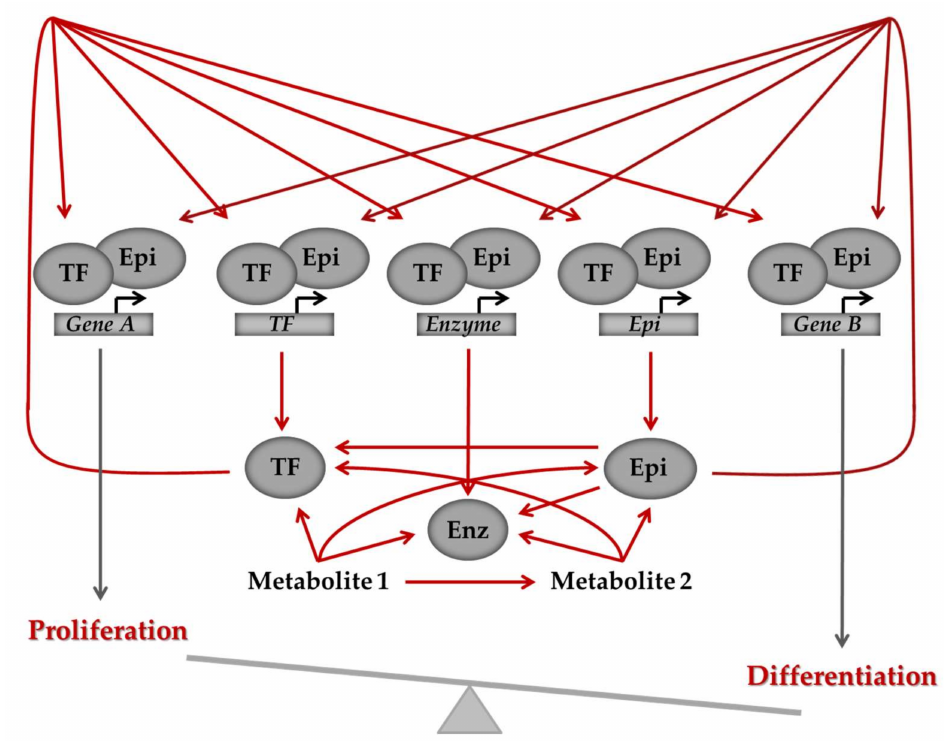
Figure 4. General model of the intricate interrelationships between the genome, metabolism and the epigenome. Defective regulation of the pathways can shift the balance between differentiation and proliferation and ultimately cause a transition from normal to malignant state. Arrows depict regulation, which can be activation or inhibition. Cross-talk between genes and metabolites is bi- directional, as illustrated by the arrows, with genes regulating metabolites, which, in turn, via their effect on epigenetic modifiers and transcription factors, signal back to the epigenome and regulate gene expression. Enz: metabolic enzyme, Epi: epigenetic regulator, TF: transcription factor.